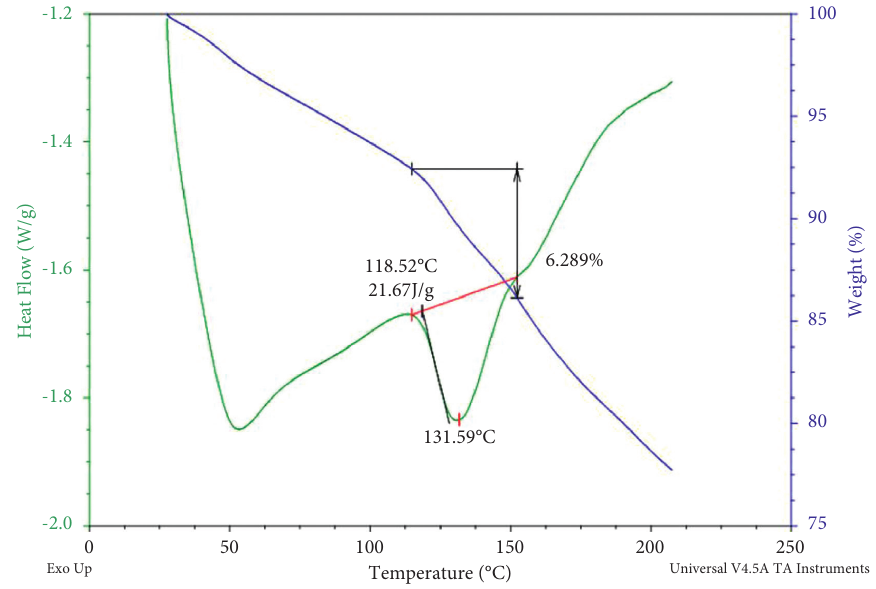
Figure 3: DSC-TGA curve of thermal analysis of